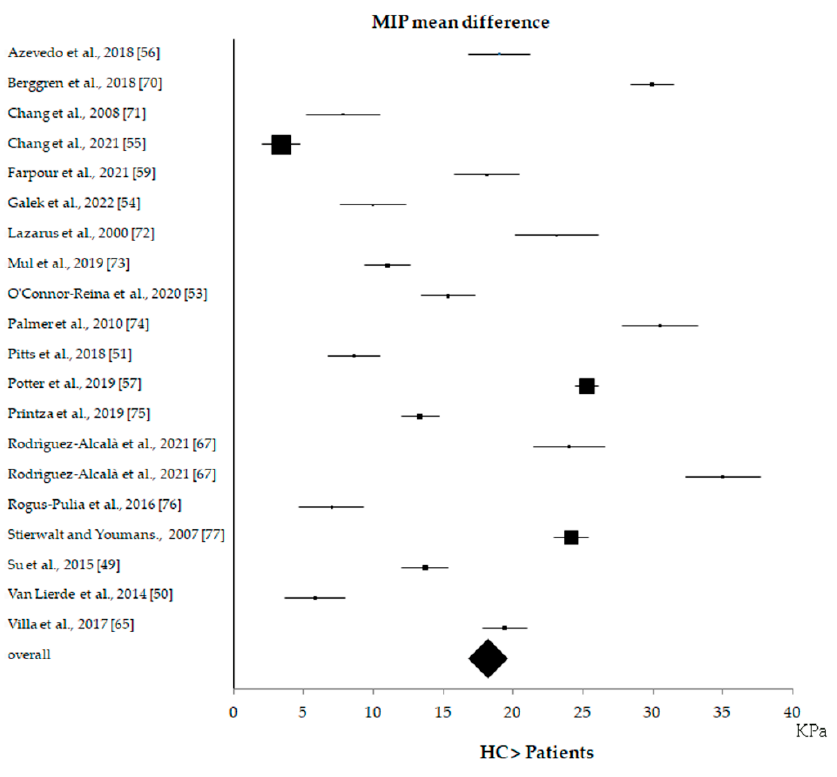
Figure 4. Forest plot of the maximum tongue pressure (MIP) results obtained from all 19 studies included in the case-control analysis. Rodriguez-Alcalà et al., 2021 [67] accounted for two values because the results pertained to two different groups of patients: patients affected by obstructive sleep apnea–hypopnea syndrome (OSAHS) and patients with primary snoring (PS). Villa et al., 2017 [65] had an interventional design, but MIP measurements of HC and patients were included in the case-control analysis.